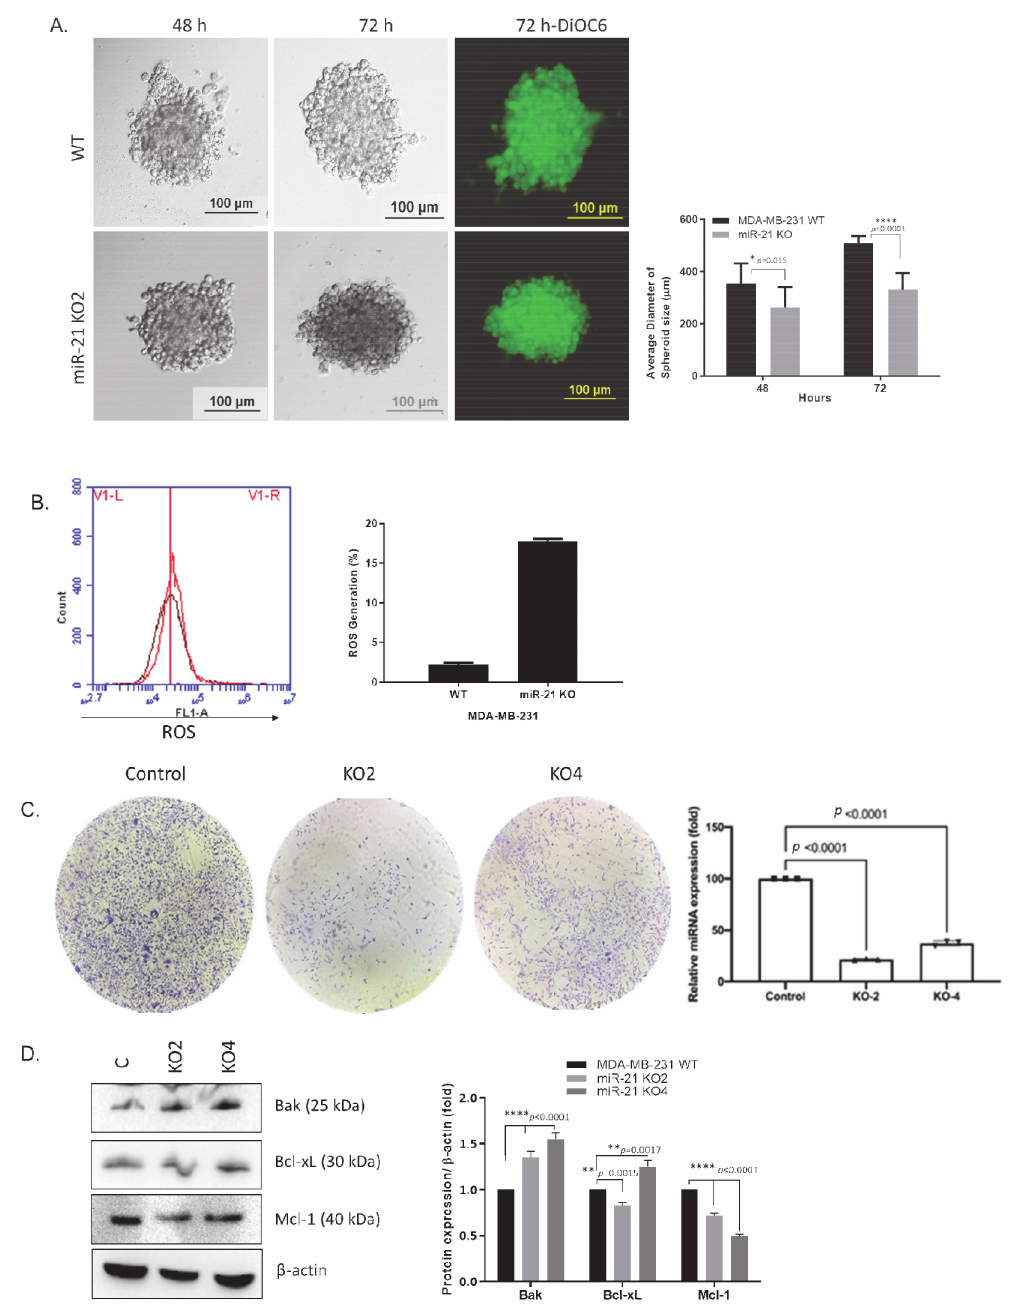
Figure 4. The silencing of miR-21 suppressed the growth of MDA-MB-231 breast cancer cells. ( A ) Hanging drop assay was adopted to understand the effect of miR-21 deletion on 3D spheroid growth of MDA-MB-231 wt and miR-21 KO2 MDA-MB- 231 cells. The spheroid size was observed at 48 and 72 h. DiOC6 staining was performed to observe the viable cells in the spheroid structure of miR-21 KO2 and wt MDA-MB-231 BCa cells at 72 h. The scale bar is 100 µ m. The average diameter of spheroids size was determined using at least ten spheroids. * p = 0.015, **** p < 0.0001 ( B ) DCFH-DA staining was used for the determination of the ROS levels following the deletion of miR-21 in MDA-MB-231 cells. Following 15 min incubation of cells with DCFH-DA, cells were harvested and analyzed by using flow cytometer FL1 channel for 1 × 10 4 events ( C ). Colony formation assay for MDA-MB-231 wt and miR-21 KO cells. The colonies were observed with crystal violet staining of cells following 14 days. ( D ) The expression levels of pro-and antiapoptotic proteins were determined by Western blotting. The densitometry graph represents protein expression levels of band intensities obtained from at least three independent experiments. The relative band intensities of each sample were calculated by normalizing against β -actin. ** p < 0.002, **** p <